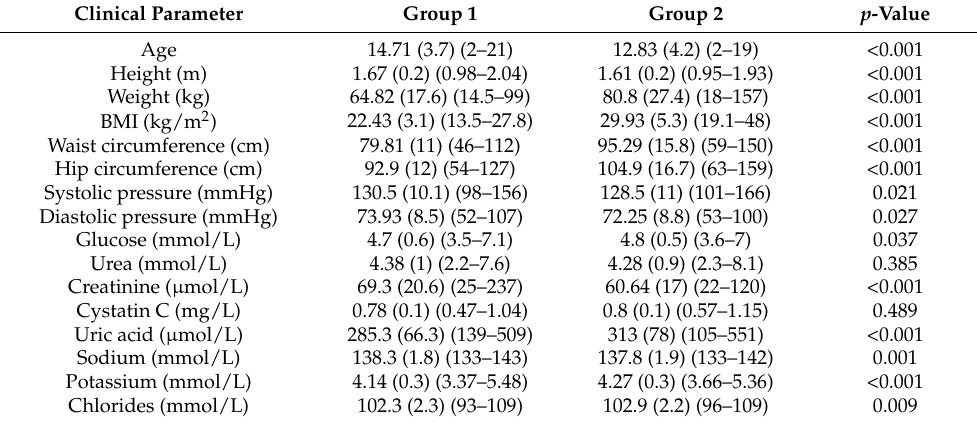
Table 2. Clinical characteristics and comparison of the subjects. The data are given as the mean value (standard deviation) (minimum–maximum) and p -value. BMI—body mass index, HDL—high-density lipoprotein, LDL—low-density lipoprotein, Lp(a)—lipoprotein (a), APOA—apolipoprotein A1, APOB—apolipoprotein B, MCV—mean corpuscular volume, MCH—mean corpuscular haemoglobin and MCHC—mean corpuscular haemoglobin